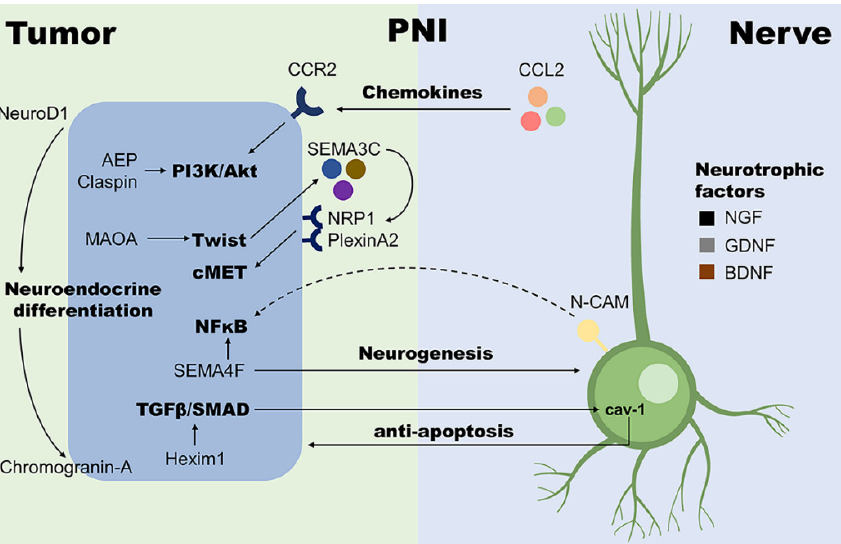
Figure 1. Examples of molecular mechanisms involved with PNI in PCa. With the help of nerve cells, tumor cells in PNI loci are more proliferative and invasive; on the other hand, the presence of tumor cells also facilitates neurogenesis. Such close interaction between tumor and nerve cells plays a central role in the development of PNI. AEP, asparaginyl endopeptidase; BDNF, brain-derived neurotrophic factor; CCL2, CC-chemokine ligand 2; CCR2, CC-chemokine receptor 2; GDNF, glial cell line-derived neurotrophic factor; Hexim1, hexamethylene bisacetamide-inducible protein 1; MAOA, monoamine oxidase A; N-CAM, neural cell adhesion molecule; NF κ B, nuclear factor kappa B; NGF, nerve growth factor; NRP1, neuropilin-1; SEMA3C, semaphorin 3C; SEMA4F, semaphorin 4F; TGF- β , transforming growth factor-beta.